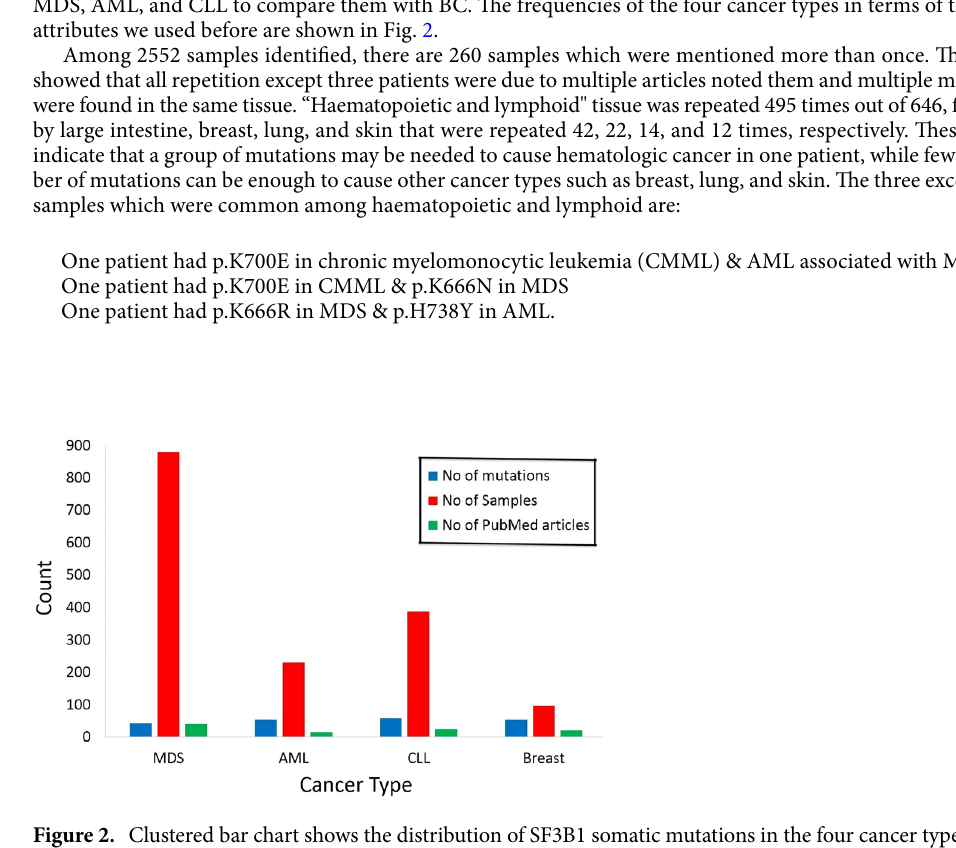
Figure 2. Clustered bar chart shows the distribution of SF3B1 somatic mutations in the four cancer types (MDS, AML, CLL, and BC), based on numbers of mutations, samples, and PubMed articles which are colored in blue, red, and green,